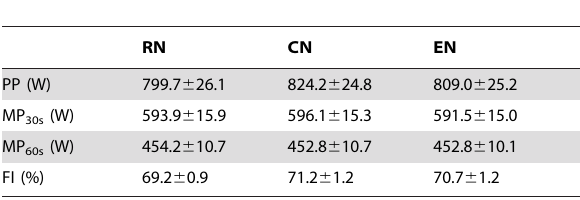
Table 1. Anaerobic power output values and Fatigue Index (mean 6 SEM) obtained during the 60-s Wingate test performed the following morning after 3 different